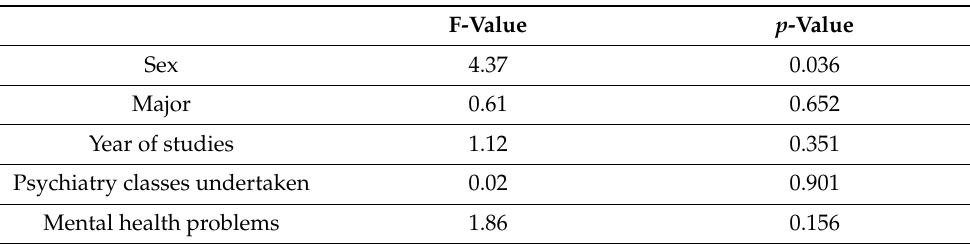
Table 6. Analysis of potential confounding